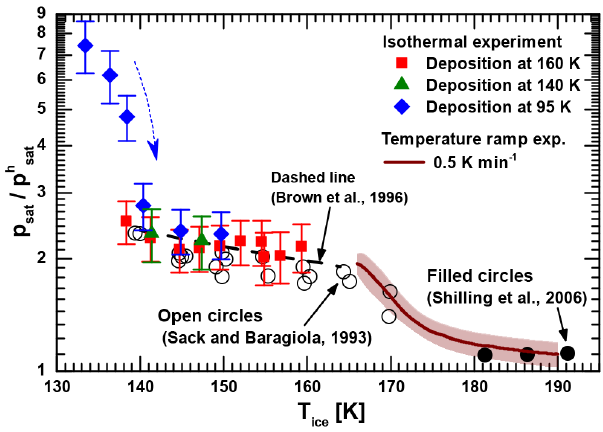
Figure 2. Measured relative saturation vapor pressure of low- temperature-deposited ices with respect to ice I h as a function of temperature. Green triangles and red squares denote isothermal vapor pressure measurements of ice samples deposited at 140 and 160K, respectively. Blue diamonds represent a series of subsequent isothermal measurements using a single ice film deposited at 95K with the arrow indicating the chronology. The brown line is the combined experimental result for the non-isothermal relative vapor pressure measurements of all ices deposited below 150 K (includ- ing a shaded interval of uncertainty). For comparison, we show data obtained for crystalline ice from the literature (see text in